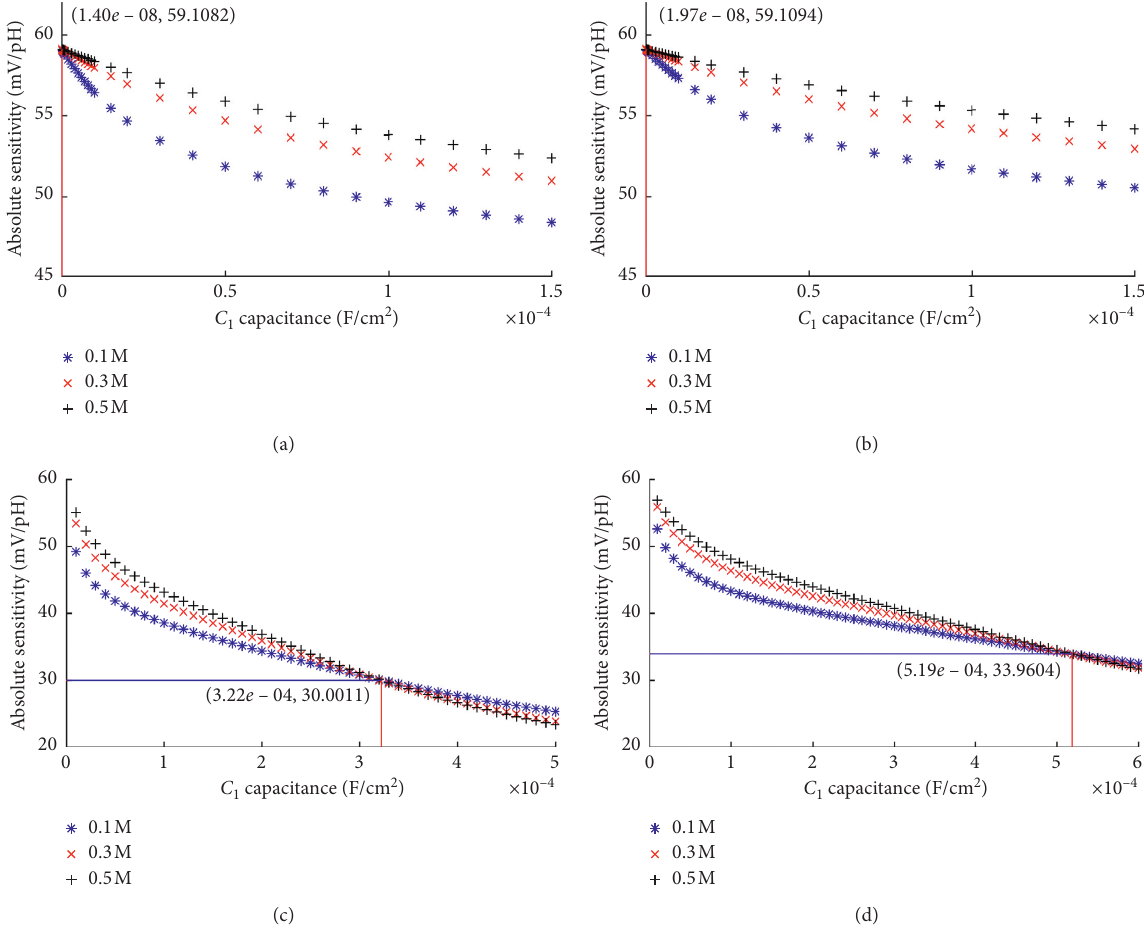
Figure 5: Absolute sensitivity against C 1 capacitance for (a) RuO 2 , N s : 12.642 (rutile: unhydrated), ε s : 55.23, (b) RuO 2 , N s : 17.642 (rutile: hydrated), ε s : 55.23, (c) TiO 2 (rutile), N s : 2.7, ε s : 80, and (d) TiO 2 , N s : 5 (rutile), ε s : 80. The electrolyte is KCl for all